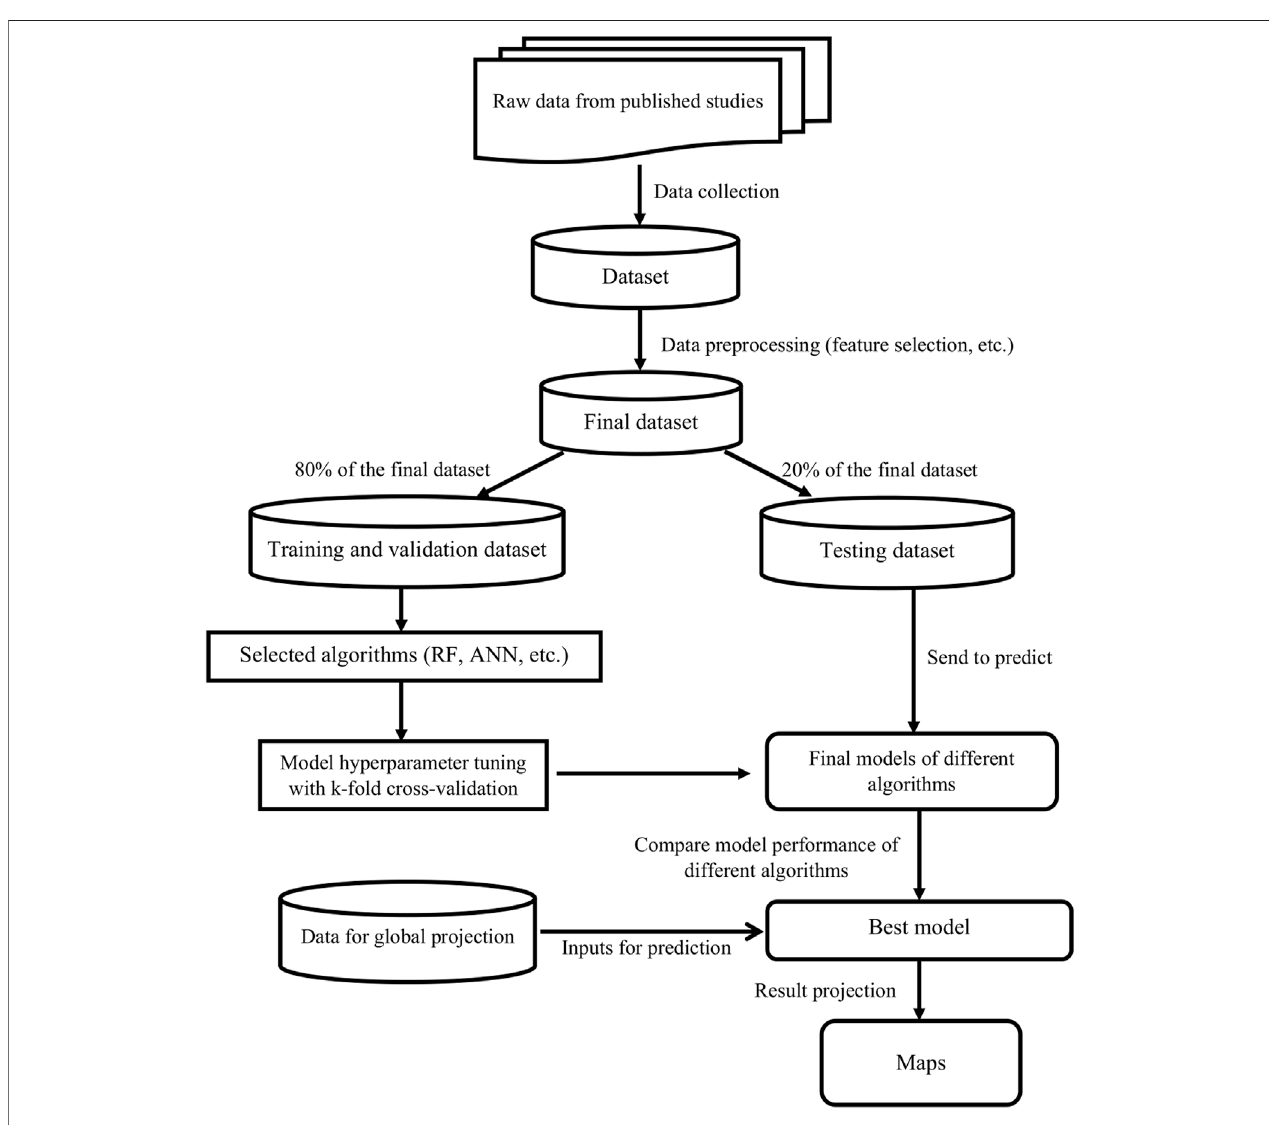
FIGURE 1 | Proposed machine learning pipeline for predicting the performance of cropping systems and comparing different algorithms.